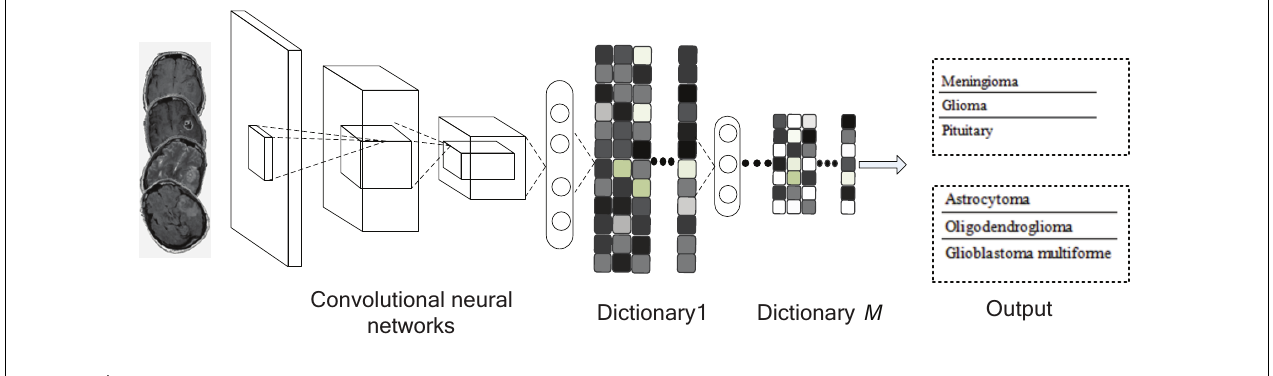
FIGURE 1 | Framework of the proposed